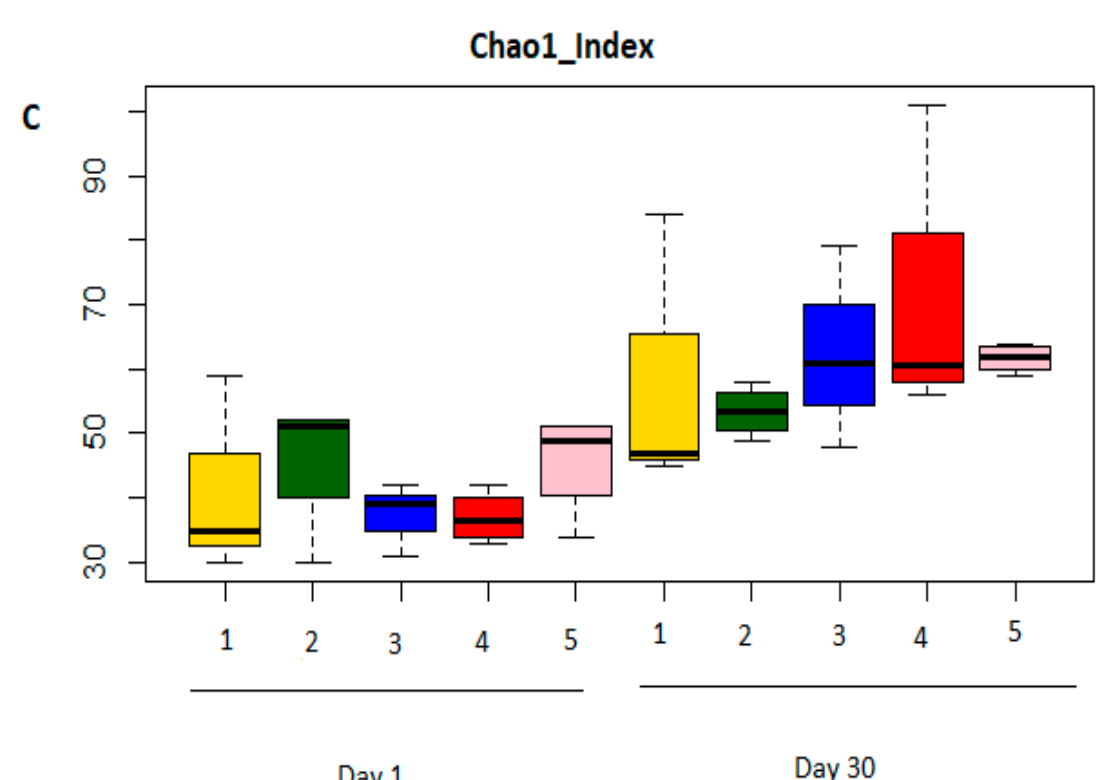
Figure 4. Alpha diversities within each treatment group at day 1 and day 30. Yellow (treatment 1), green (treatment 2), blue (treatment 3), red (treatment 4) and pink (treatment 5). Three indices were measured: Shannon index ( A ), Simpson evenness ( B ) and Chao1 ( C ). The top and bottom boundaries indicate the 75th and 25th quartile values, respectively. The horizontal lines within each box represent median values.